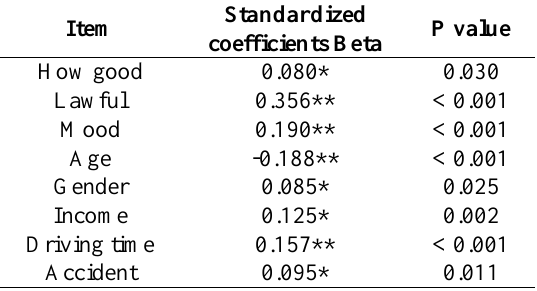
Table 6. Predictors of factor 1 (violation)